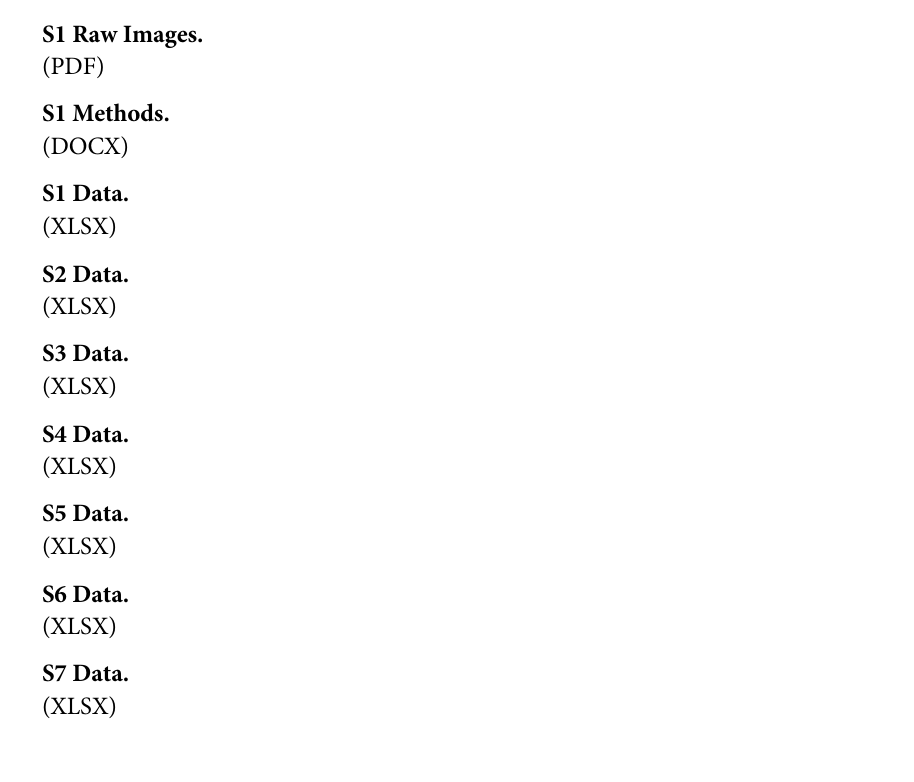
S9 Fig. Phagocytic activity in HIV-1 Tat–exposed HPAs. Representative immunocytochem- istry images showing the phagocytic potential of GFAP + HPAs in control and Tat–exposed cells (3.57 nM; 24 hours). Scale bar, 10 μ m. n = 6. GFAP, glial fibrillary acidic protein; HPA, human primary astrocyte; Tat, transactivator of transcription. (TIF) S10 Fig. HIV-1 Tat–mediated amyloidosis in human neurons. qPCR analysis showing expression of APP, BACE1, BACE1-AS, HIF-1, and PHD-2 mRNAs in human primary neu- rons exposed to HIV-1 Tat (3.57 nM, 24 hours). GAPDH was used as an internal control for mRNA expression (A). qPCR analysis showing expression of APP, BACE1, BACE1-AS, HIF-1, and PHD-2 mRNAs in SHSY-5Y cells exposed to HIV-1 Tat (3.57 nM, 24 hours). GAPDH was used as an internal control for mRNA expression (B). Western blot analysis showing expression of HIF-1 α , BACE 1, APP, A β mOC64, and PHD-2 proteins in SHSY-5Y cells exposed to HIV-1 Tat (3.57 nM, 24 hours). β -actin was used as an internal control (C). qPCR analysis showing expression of APP, BACE1, BACE1-AS, HIF-1 α , and PHD-2 mRNAs in SHSY-5Y cells exposed to HIV-1 Tat (3.57 nM, 48 hours). GAPDH was used as an internal control for mRNA expression (D). Western blot analysis showing expression of HIF-1 α , BACE 1, APP, A β mOC64, and PHD-2 proteins in SHSY-5Y cells exposed to HIV-1 Tat (3.57 nM, 48 hours). β -actin was used as an internal control (E). Data are presented as mean ± SEM; n = 6. Student t test was used to determine the statistical significance: � P < 0.05 versus control. The data underlying this figure may be found in S16 Data. APP, amyloid precursor protein; A β , amyloid beta; BACE1, β -site cleaving enzyme; BACE1-AS, BACE1-antisense transcript; GAPDH, glyceraldehyde 3-phosphate dehydrogenase; HIF-1 α , hypoxia inducible factor-1 α ; PHD-2, prolyl hydroxylase 2; qPCR, quantitative polymerase chain reaction; SHSY-5Y, neuro- blastoma cell line; Tat, transactivator of transcription (TIF) S1 Raw